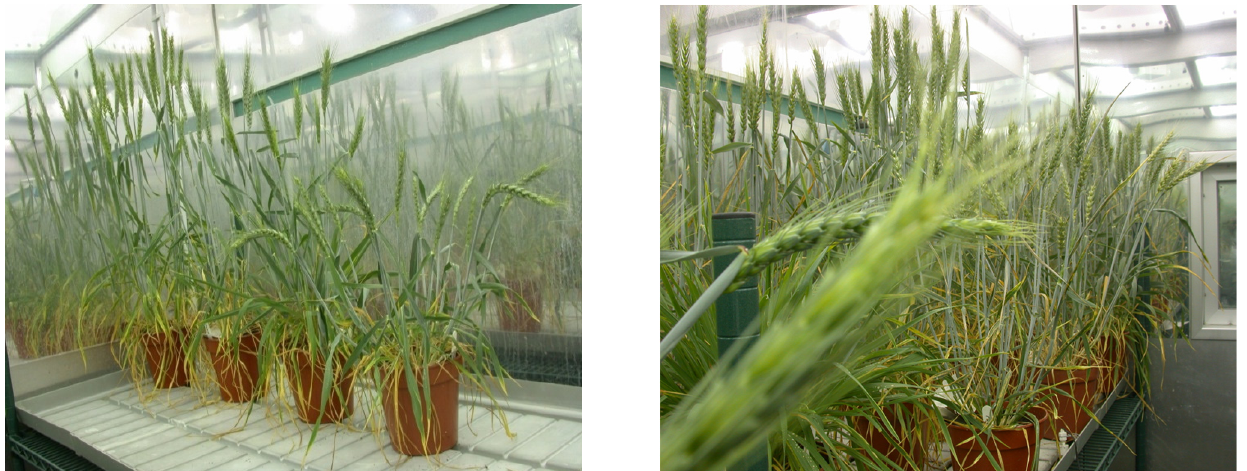
Figure 1. The Rht plants ( Rht-B1b, Rht-D1b, Rht-B1c, Rht-D1c ) and Mercia in pots in the growth cabinet during the experiment . Water was supplied automatically.